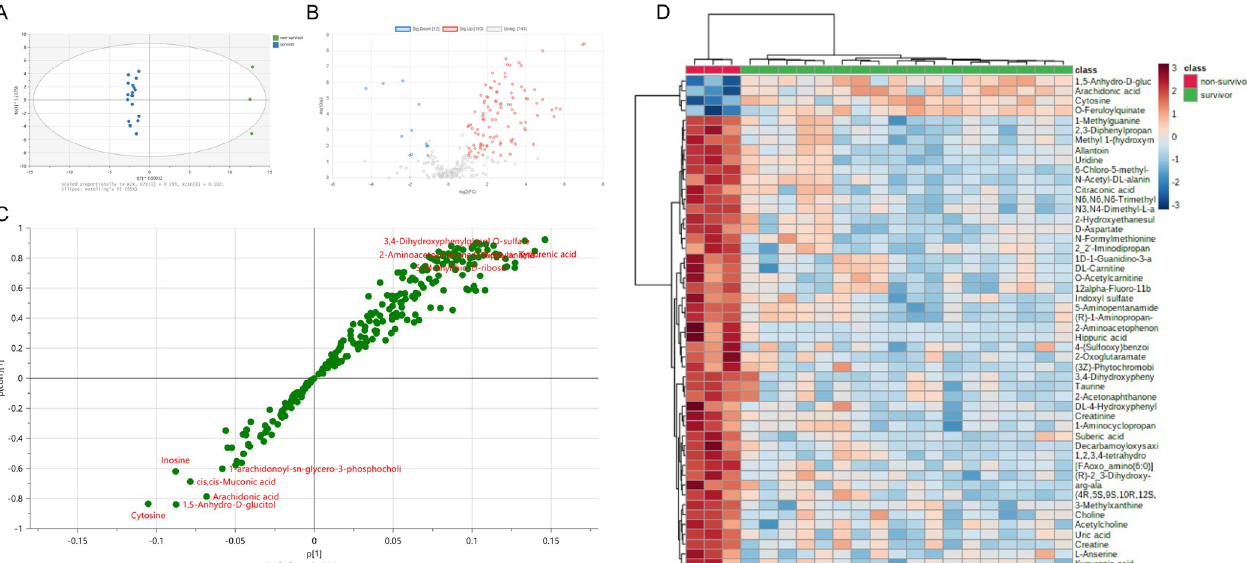
PLOS ONE | https://doi.org/10.1371/journal.pone.0271137 July 8,